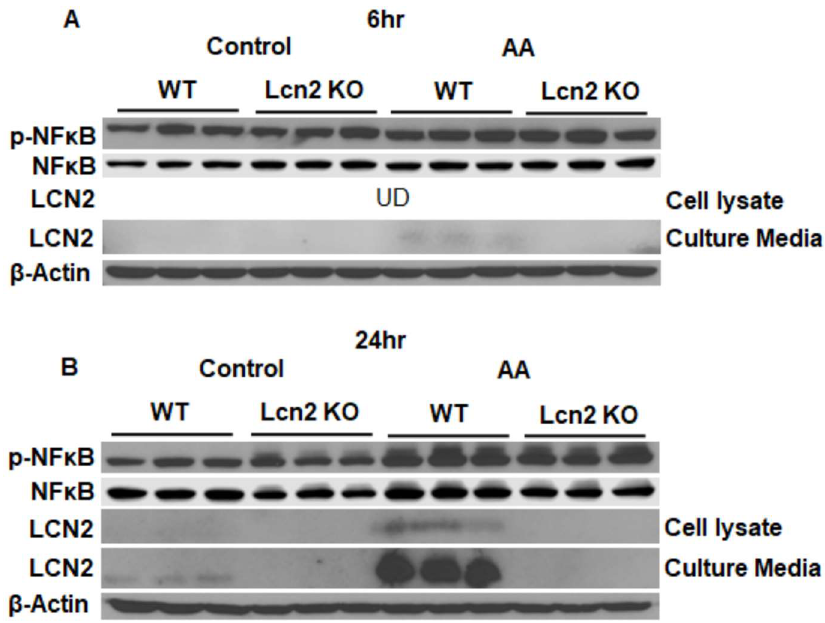
Figure 1. Regulation of Lcn2 expression and secretion by AA in differentiated inguinal adipocytes. Lcn2 expression and secretion and NFkB phosphorylation in inguinal adipocytes treated with 150 nM AA for 6 h ( A ) and 24 h ( B ). n = 3.